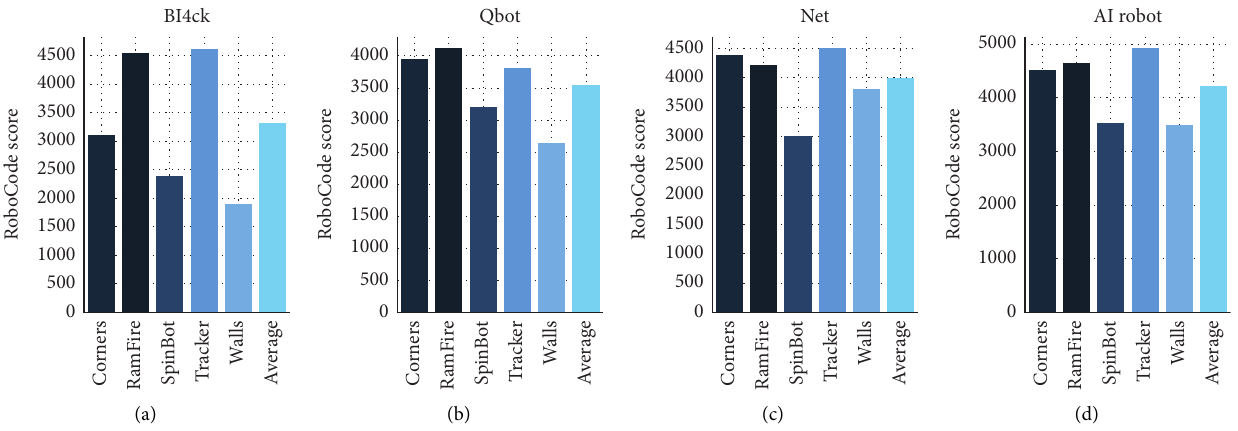
Figure 11: Scores are represented between AI robot and community robots against standard robots. Table 1: The T- test results between the AI robot and Corners and Wall robots. Corners vs. AI robot Walls vs. AI